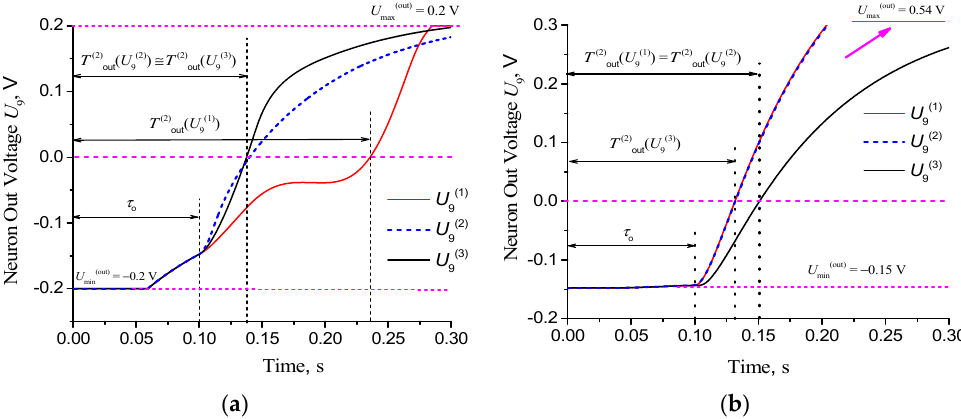
Figure 12. Diagrams of the output voltages of the neuron U 9 ( t ) of the networks IHN1 ( a ) and IHN2 ( b ) for the input template C (Figure 11) for various voltage transfer coefficients: K I ( a ) and K R ( b ). Calculation parameters are in Table 4. The arrow in Figure 12b shows the trend of U 9 ( t ) to U max(out) with t →∞